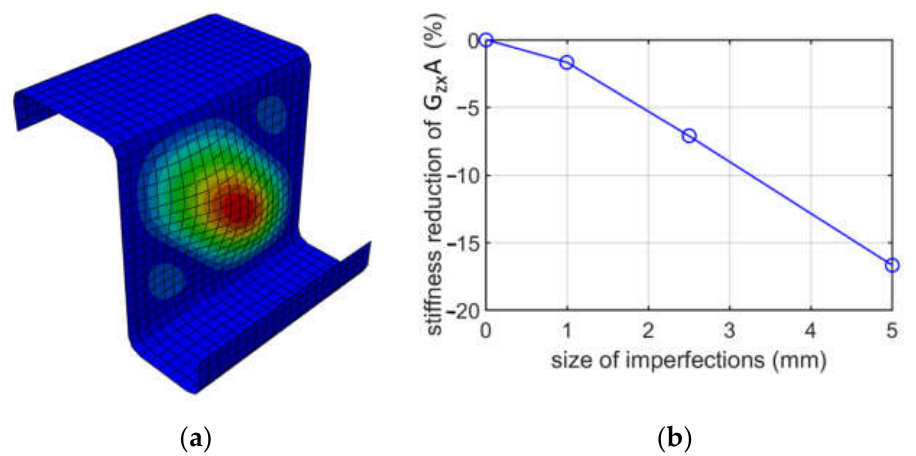
Figure 11. Buckling due to shearing for case (i) for the Z profile with an elongation of 100 mm: ( a ) mode 1; ( b ) plot of the stiffness reduction of G zx A , depending on the size of imperfections.